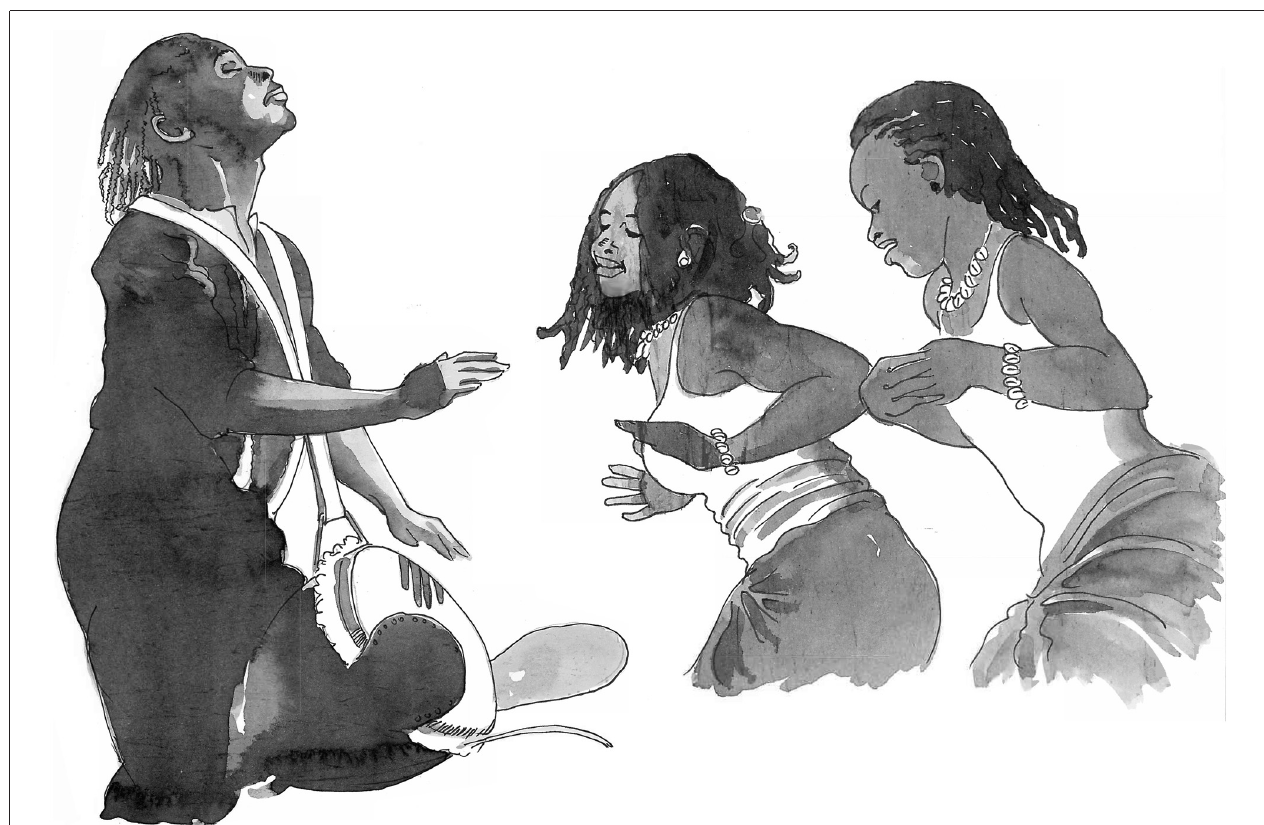
FIGURE 1 | Dance and drumming. The painting illustrates how, in many musical traditions, music (here, djembe drumming) and dance are equally important components of a participatory social music experience (painting by the